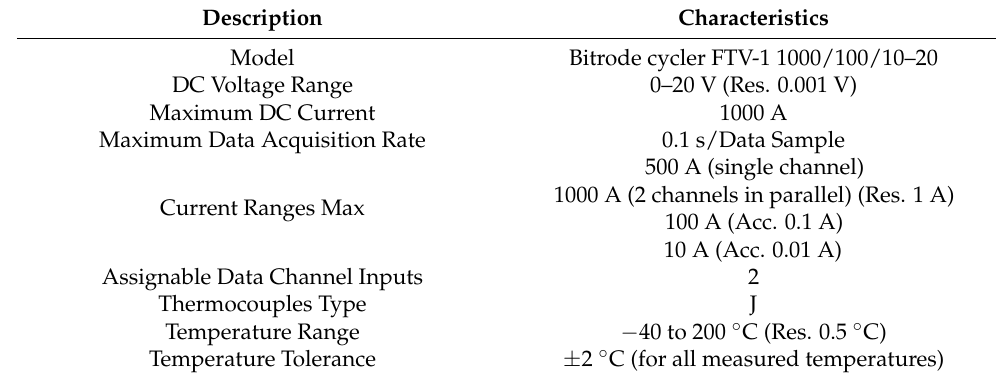
Table 6. Cycler main features.